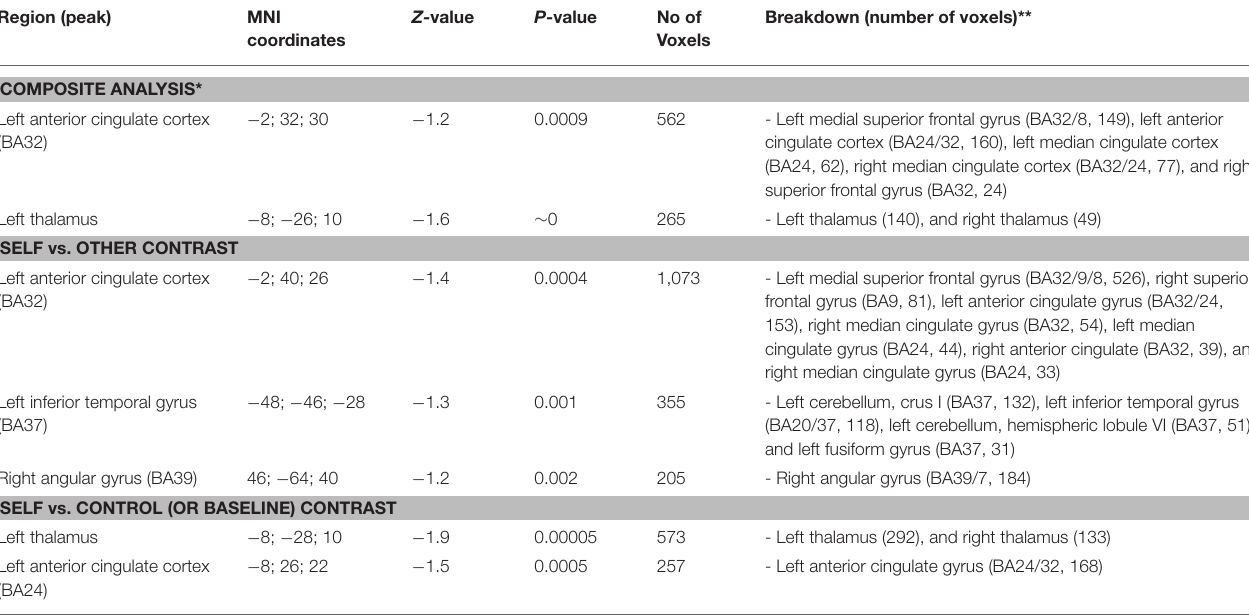
TABLE 2 | Meta-analysis of brain activations during self-processing in schizophrenia patients relative to controls. Z- value P -value Region (peak) MNI coordinates COMPOSITE